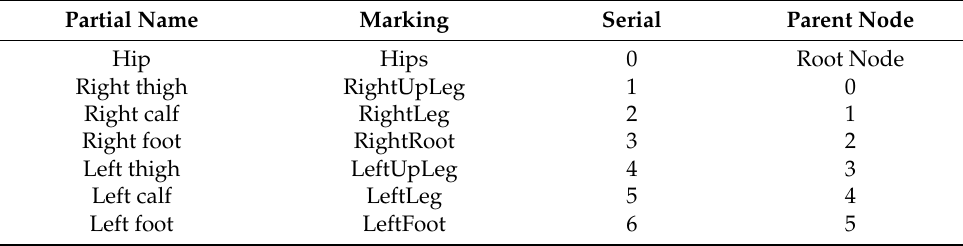
Table 2. Table of body part names